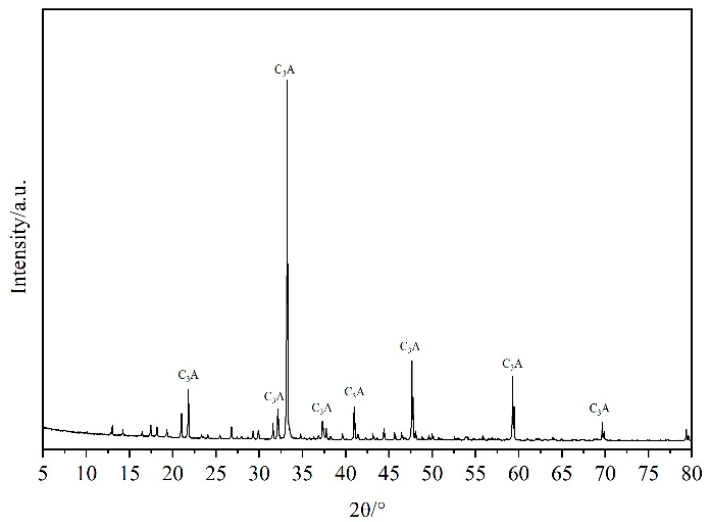
Figure 4. XRD pattern of C 3 A.